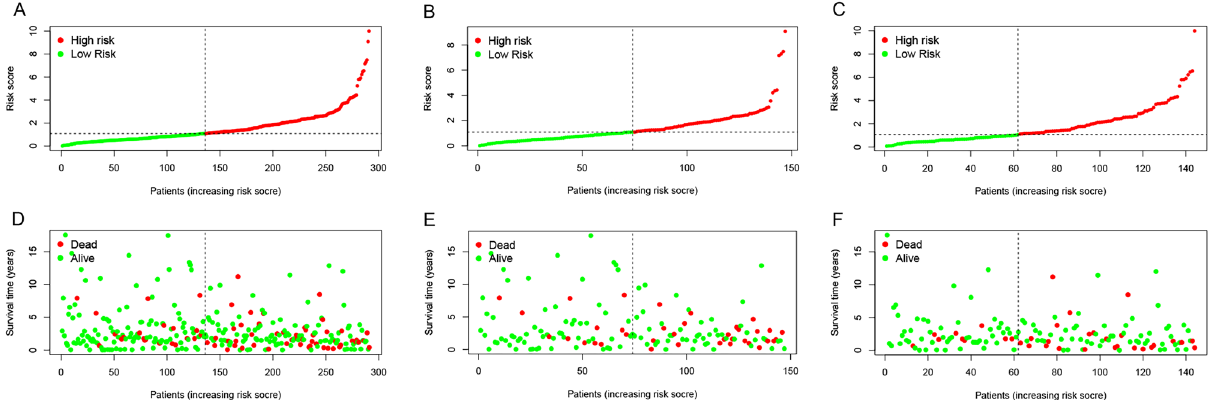
Figure 6. Distribution of risk scores in CESC patients. ( A – C ) Distribution and median value of risk scores of patients in the TCGA cohort and two validation data sets; ( D – F ) Distribution of OS status and risk scores of patients in the TCGA cohort and the two validation data